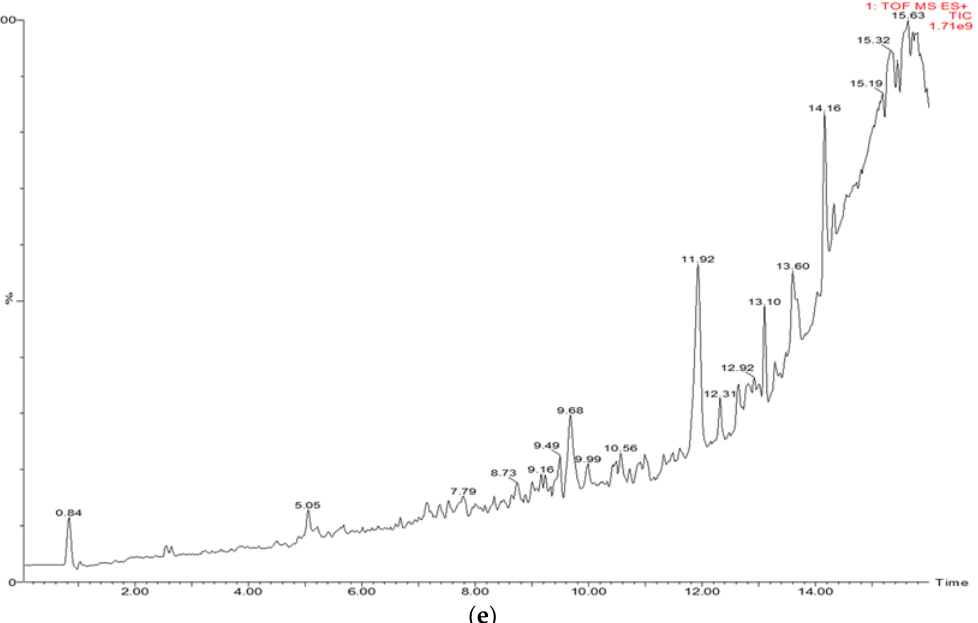
Figure 1. Effect of Pj-EE and its solvent fractions on the production of NO, cell viability profile, and phytochemical constituents of Pj-EE-CF. ( a , d ) Supernatant NO levels on LPS (1 μ g/mL)-induced RAW264.7 cells pretreated with 100 μ g/mL of Pj-EE, Pj-EE-HF, Pj-EE-CF, Pj-EE-BF, or Pj-EE-WF ( a ) and with the indicated concentrations of PJ-EE-CF ( d ) were analyzed using the Griess assay. ( b , c ) Cell viability of RAW264.7 cells upon treatment with Pj-EE, Pj-EE-HF, Pj-EE-CF, Pj-EE-BF, or Pj-EE-WF ( b ) and PJ-EE-CF ( c ) at the same concentration on NO assay were analyzed using an MTT assay. ( e ) The phytochemical screening performed on Pj-EE-CF using LC/MS-MS chromatogram. Results ( a – d ) are expressed as mean standard deviation. ## p < 0.01 compared to normal group (no treatment), and * p < 0.05, ** p < 0.01 compared to control group (LPS alone) by one-way ANOVA.